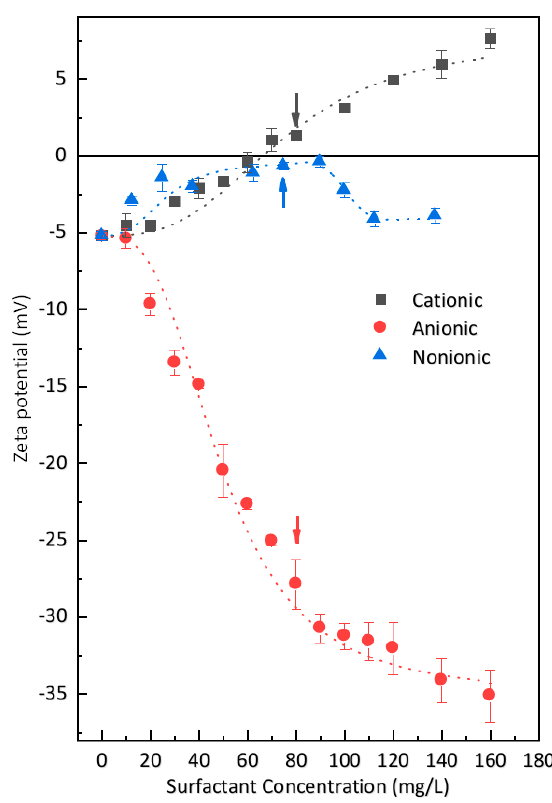
Figure 7. Changes in zeta potential of cement particles with increasing surfactant concentration. Arrows signify the concentration of each surfactant required to reach 10% air content in fresh mortars. Dotted lines are guides for the eyes.